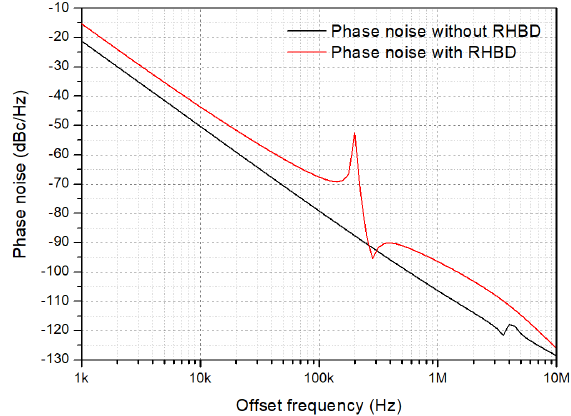
Figure 9. VCO phase